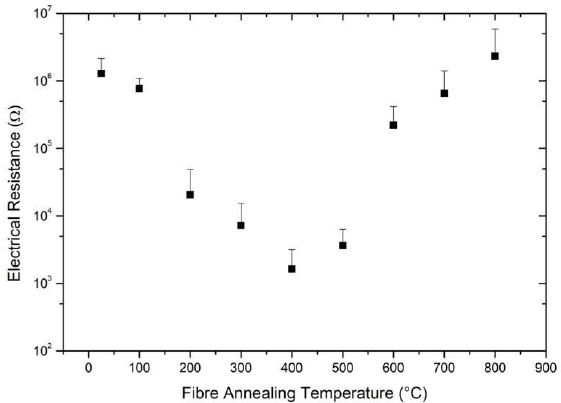
Figure 6. A semi-log plot of CNT fiber average electrical resistance as a function of annealing temperature in a tube furnace. Electrical resistance drops to a minimum point followed by an irreversible increase.